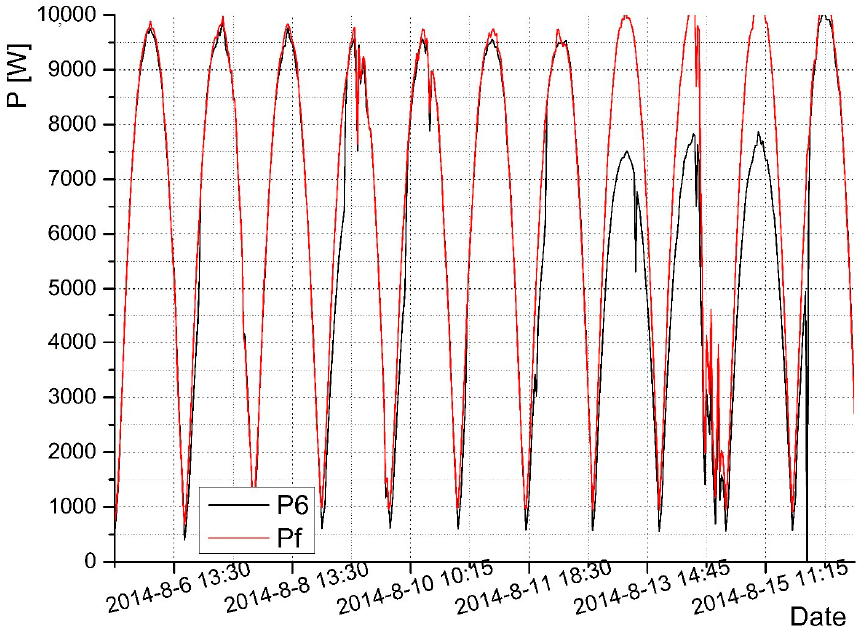
Figure 5. Fault in a string during June 2014.